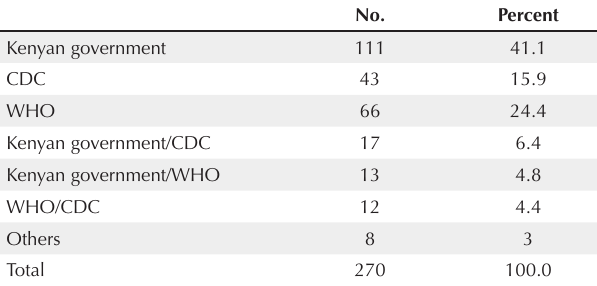
Table 6. Source of Information on Yellow Fever Guidelines